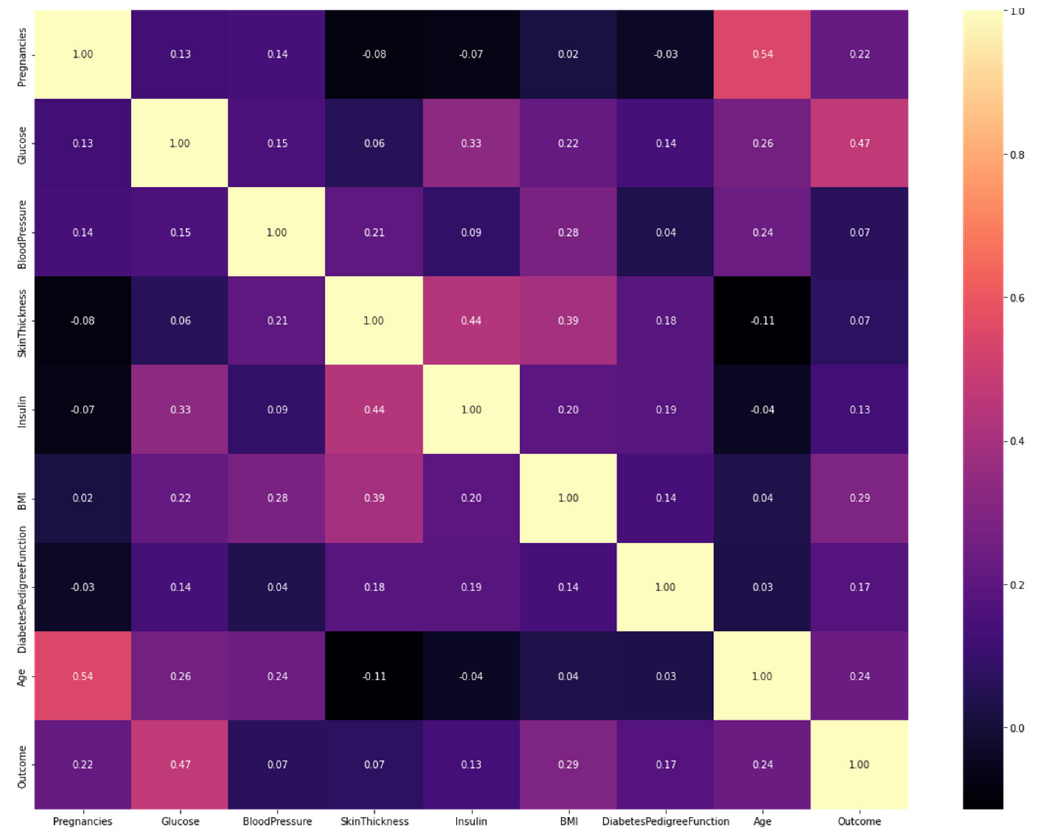
Figure 7. Confusion matrix. Table 5. Performance comparison of the generated prediction models.